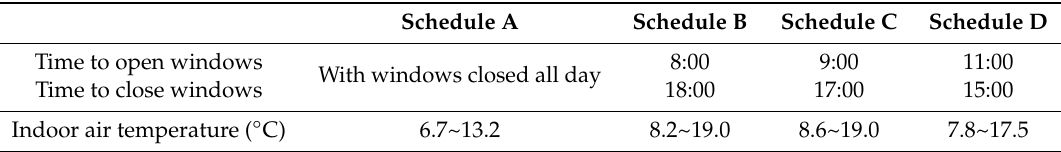
Table 3. Indoor air temperature ranges under di ff erent window schedules.